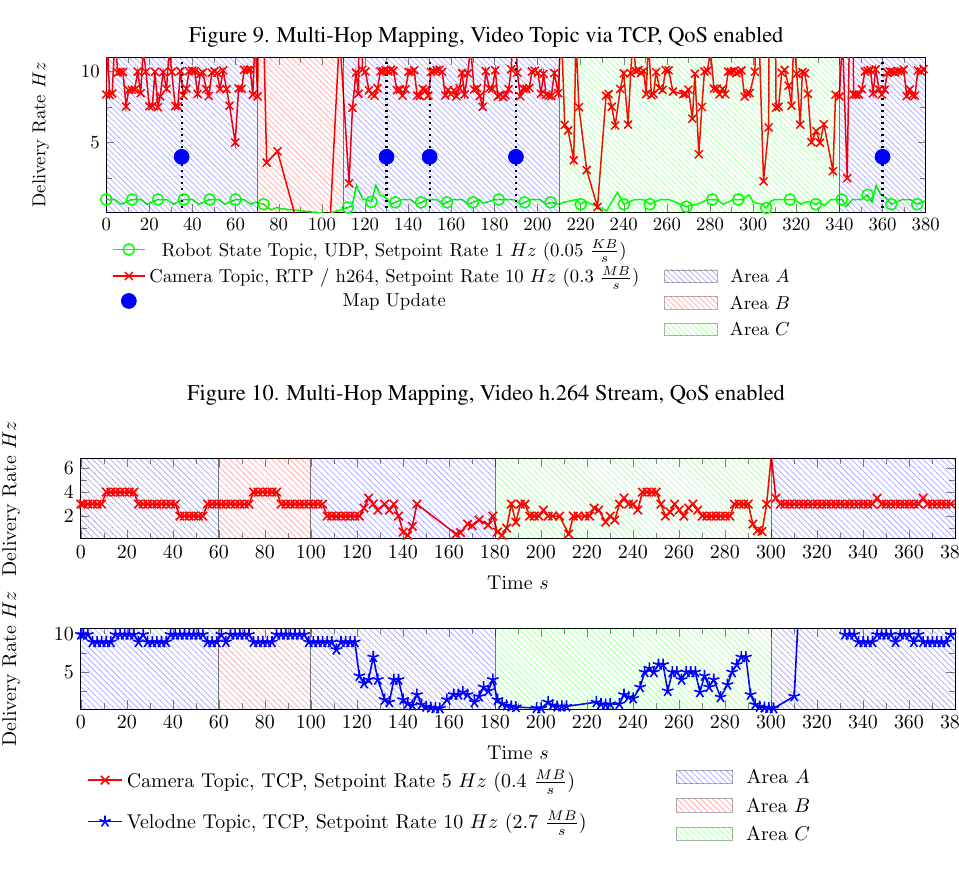
Figure 11. Multi Hop Mapping, Video Topic via TCP, Velodyne Topic via TCP, Relay station